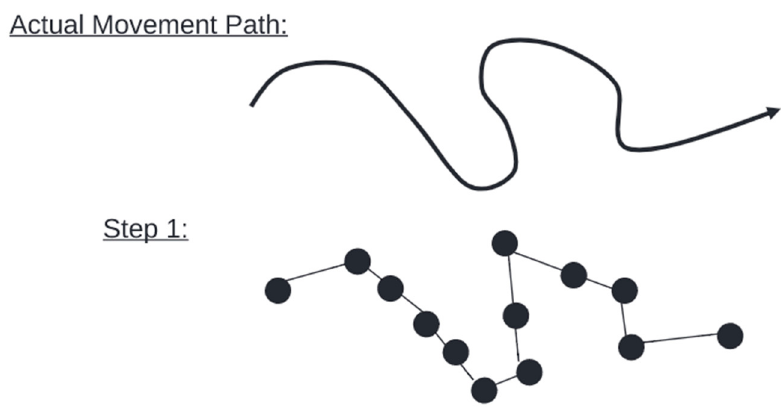
Figure 2. Conceptual diagram of step length from Edelhoff et al. 2016 [82].